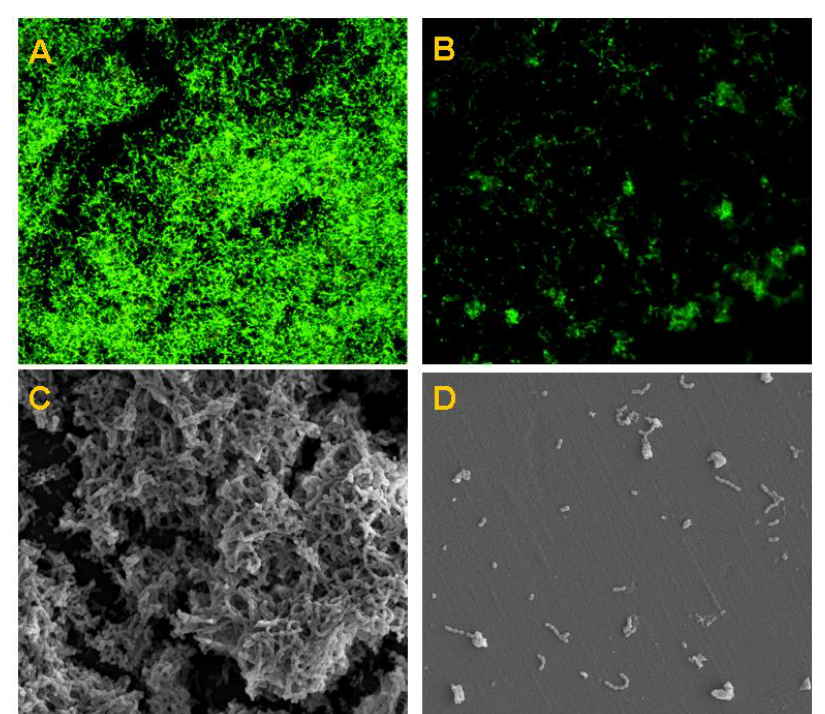
Figure 3. Effect of the Nano-MIX on the multi-species biofilms of S. mutans , F. nucleatum , A. actinomycetemcomitans , and P. gingivalis at 24 h. The confocal scanning laser microscopy (CLSM) ( A , B